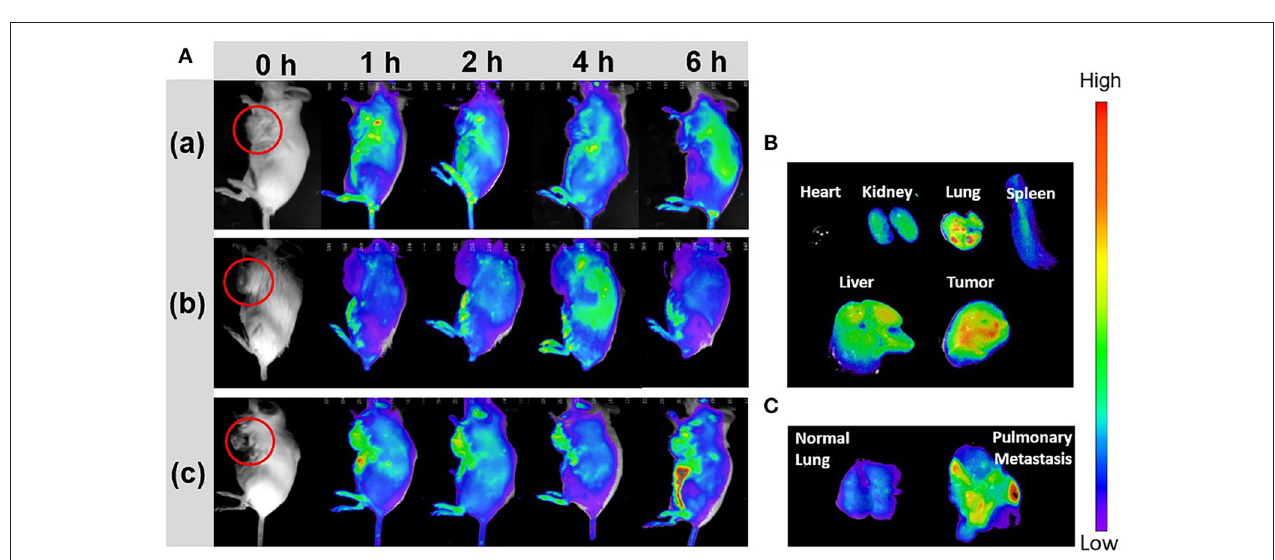
FIGURE 5 | In vivo fluorescence imaging. (A) 4T1 breast cancer bearing mice were imaged in 1, 2, 4, 6h after i.v. injection with free Ce6 (a), ABN@Ce6 NPs (b), and ABN@HA-sese-Ce6/CYC NPs (c). (B) Florescence images of excised heart, kidney, lung, spleen, liver, and tumor in ABN@HA-sese-Ce6/CYC NPs treated group. (C) Florescence images of normal lung and pulmonary metastasis after injection with ABN@HA-sese-Ce6/CYC NPs.